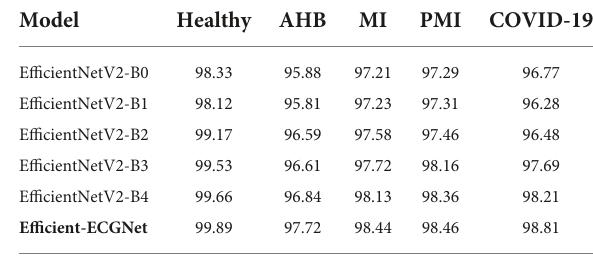
TABLE 3 Class-wise performance in terms of accuracy with base models.